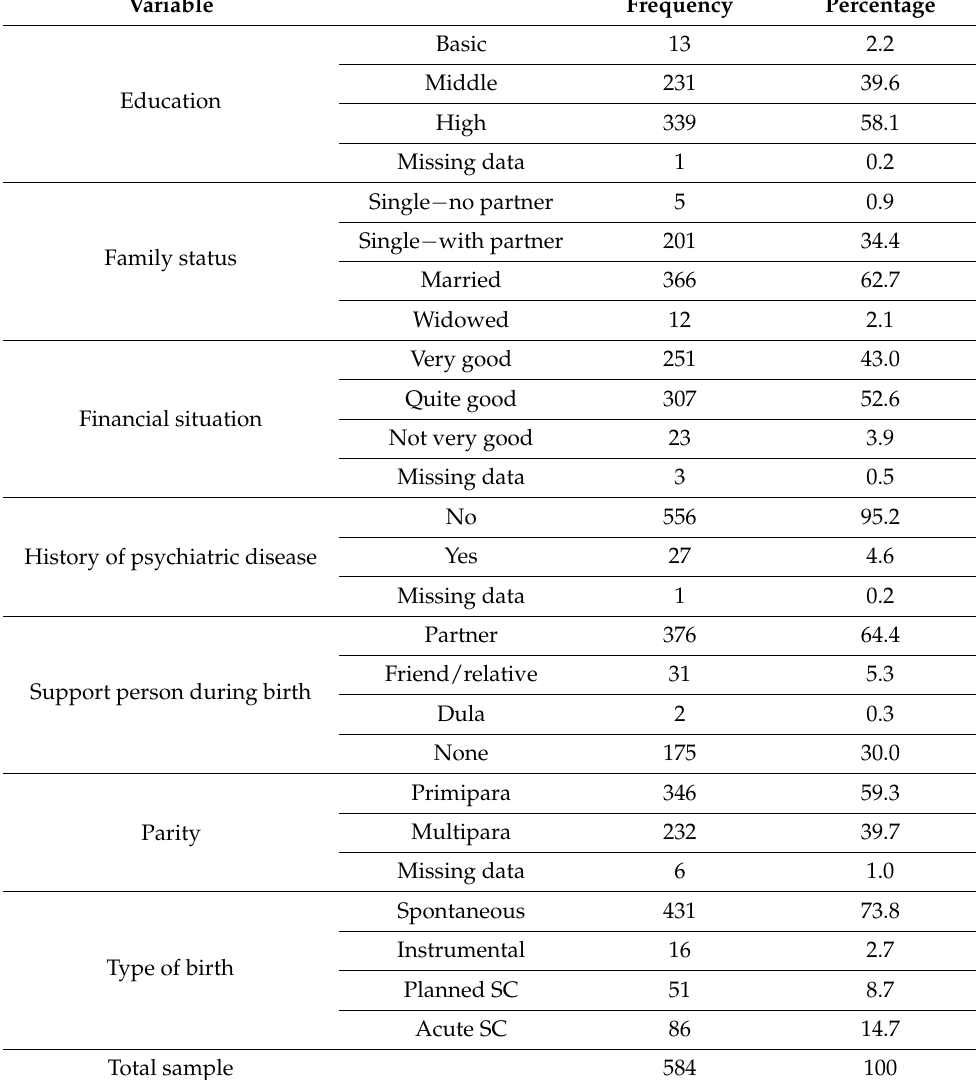
Table 1. Demographic and perinatal description of the study